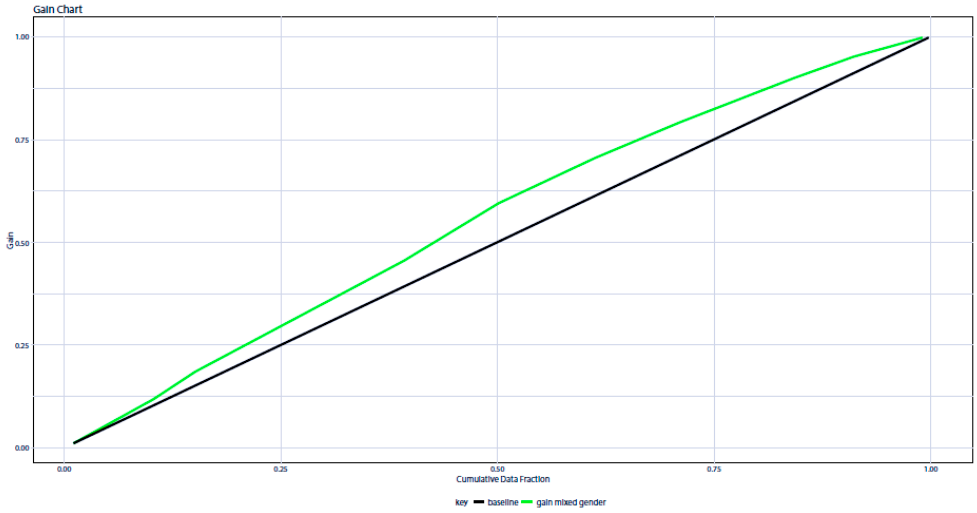
Figure 4. Gain chart for the mixed student sample.